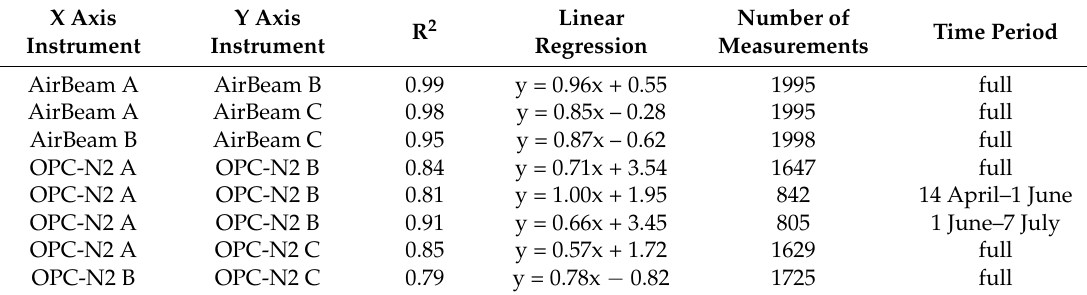
Table 2. Correlation and linear regression of sensor measurements.